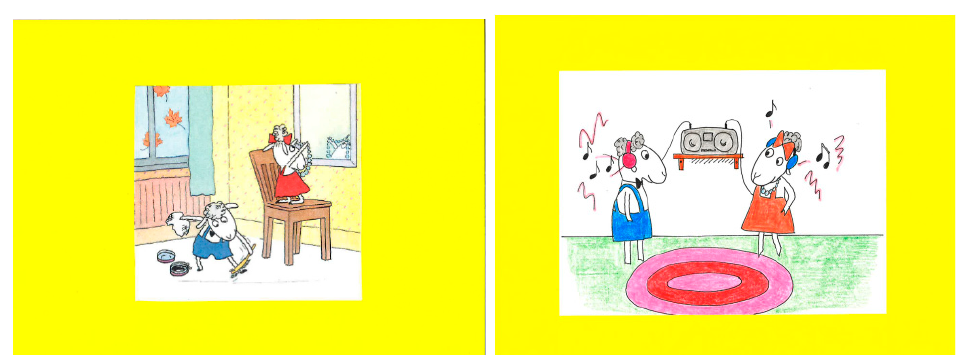
Figure A1. Examples from the Picture-Story Paul et Pauline font la fête “Paul and Pauline are having a party”, Eliciting Singular and Plural Verb Forms.